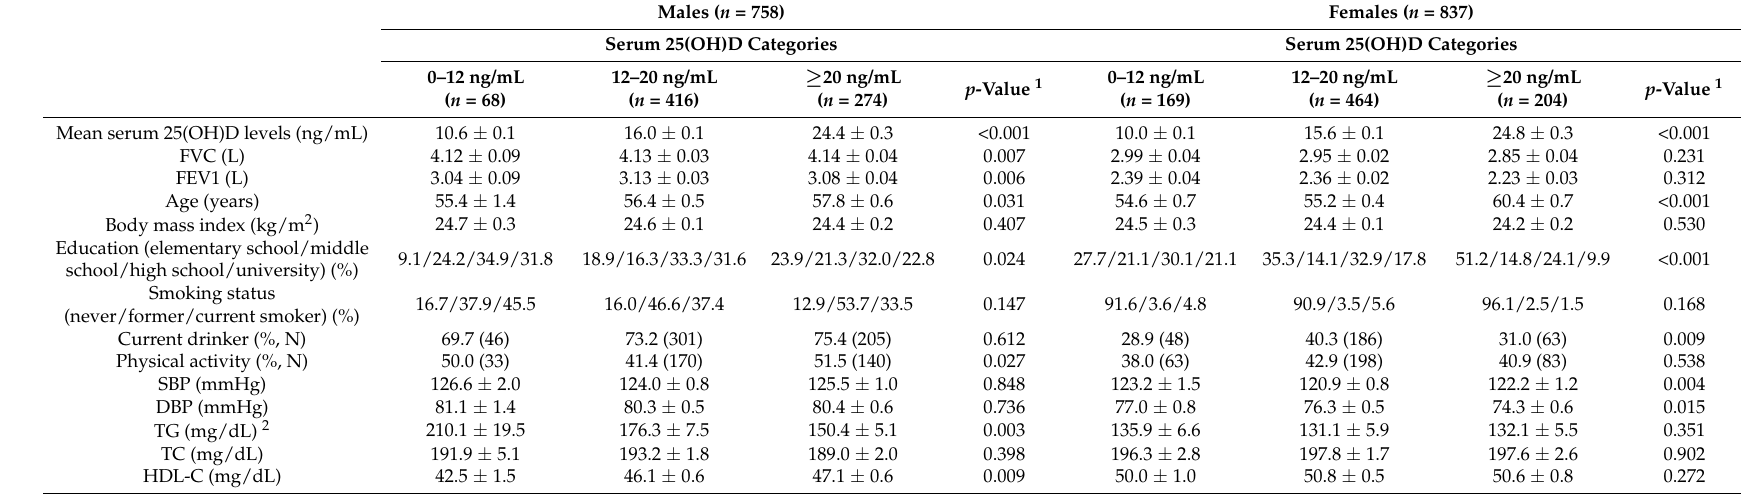
Table 3. Characteristics of study participants based on serum 25-hydroxyvitamin D (25(OH)D) categories and